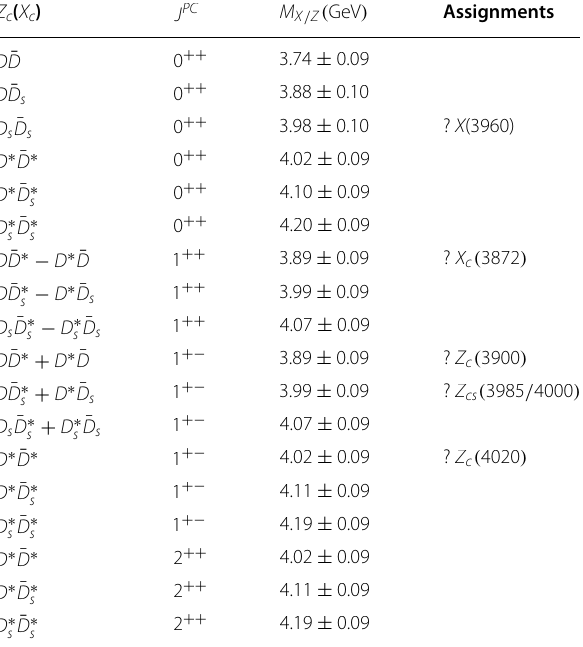
Table 2 The possible assignments of the ground state hidden‑ charm molecular states, the isospin limit is implied. The molecular states with the constituents D ∗ and D ∗ s are taken from Ref. [17]